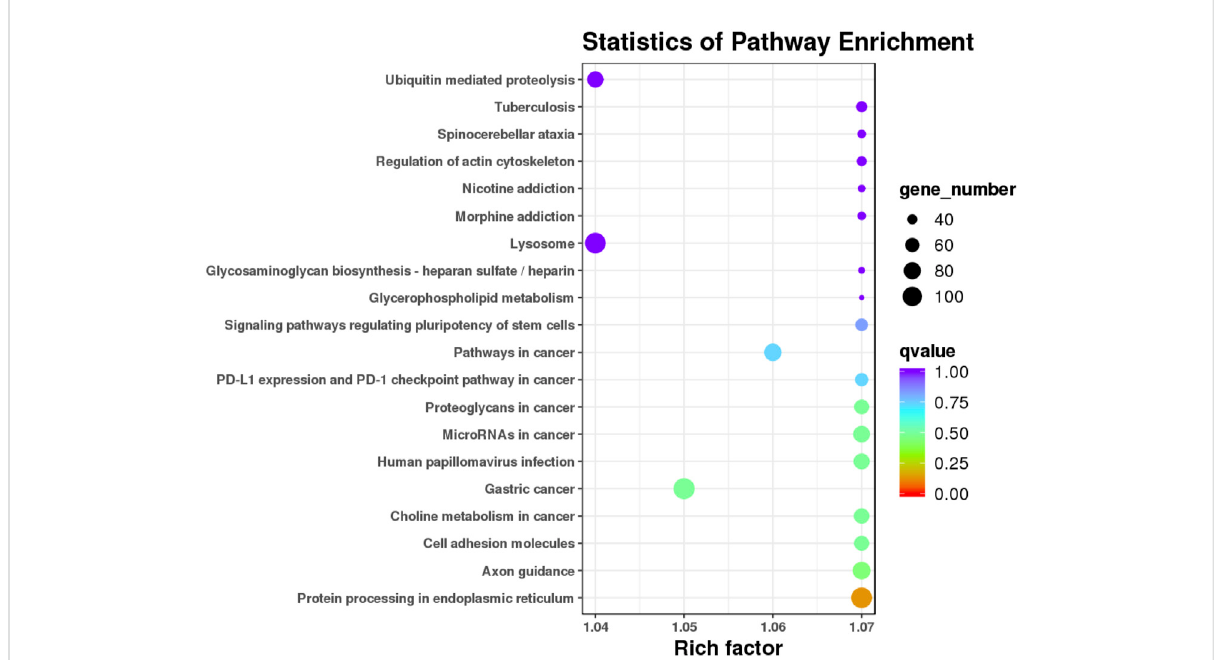
FIGURE 6 KEGG pathway analysis of the target genes of known differential expressed miRNAs in AR patients compared with non-AR patients. Horizontal axis: Rich factor. The larger the point, the higher the enrichment degree, the more candidate target genes in this pathway, and the color of the point correspond to a different q value range. Vertical axis: The de fi nition of the pathway.